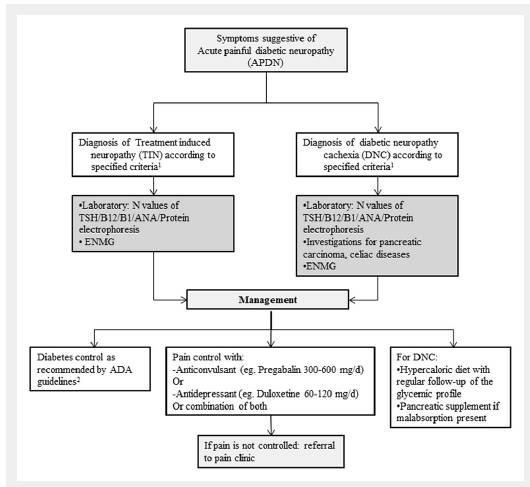
stimulating hormone 1 Reference: Table 2 2 ADA = American diabetes